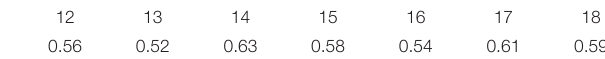
TABLE 3 | The non-majority opinion rates by terms for the Roberts Court. Term